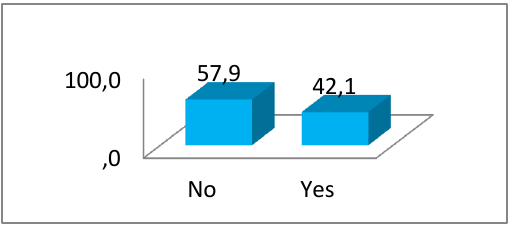
Figure 3: Publicizing the local tourist